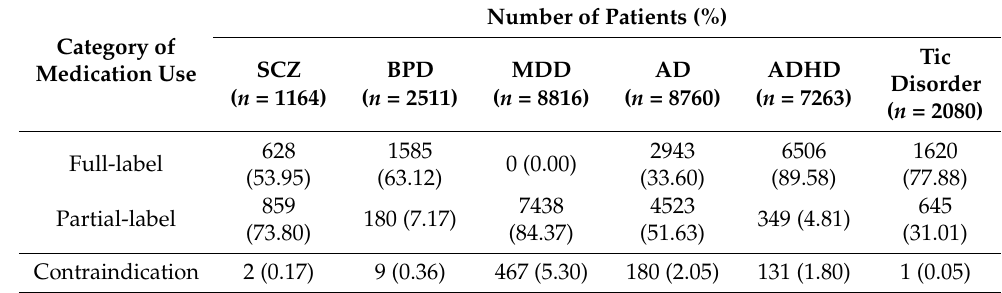
Table 4. Frequency of prescribed medication according to regulatory information by psychiatric